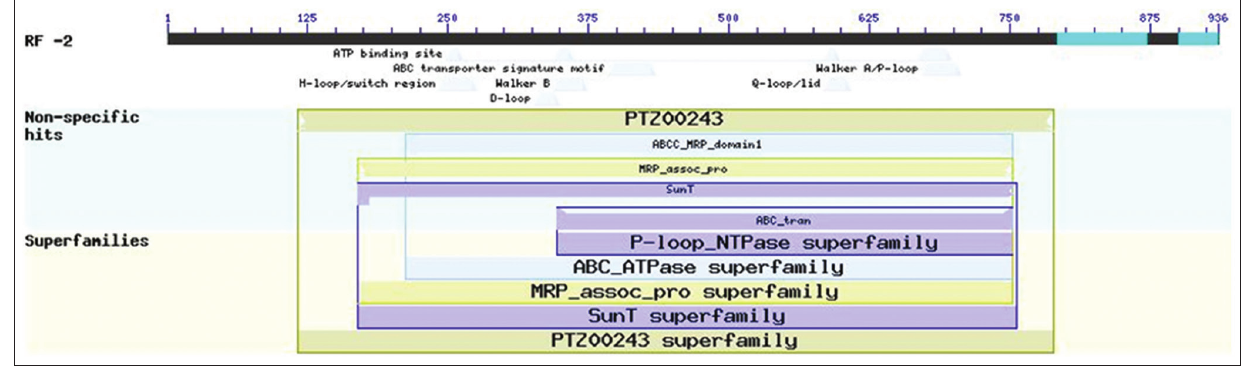
Figure-2: The results analysis of conserved protein using online